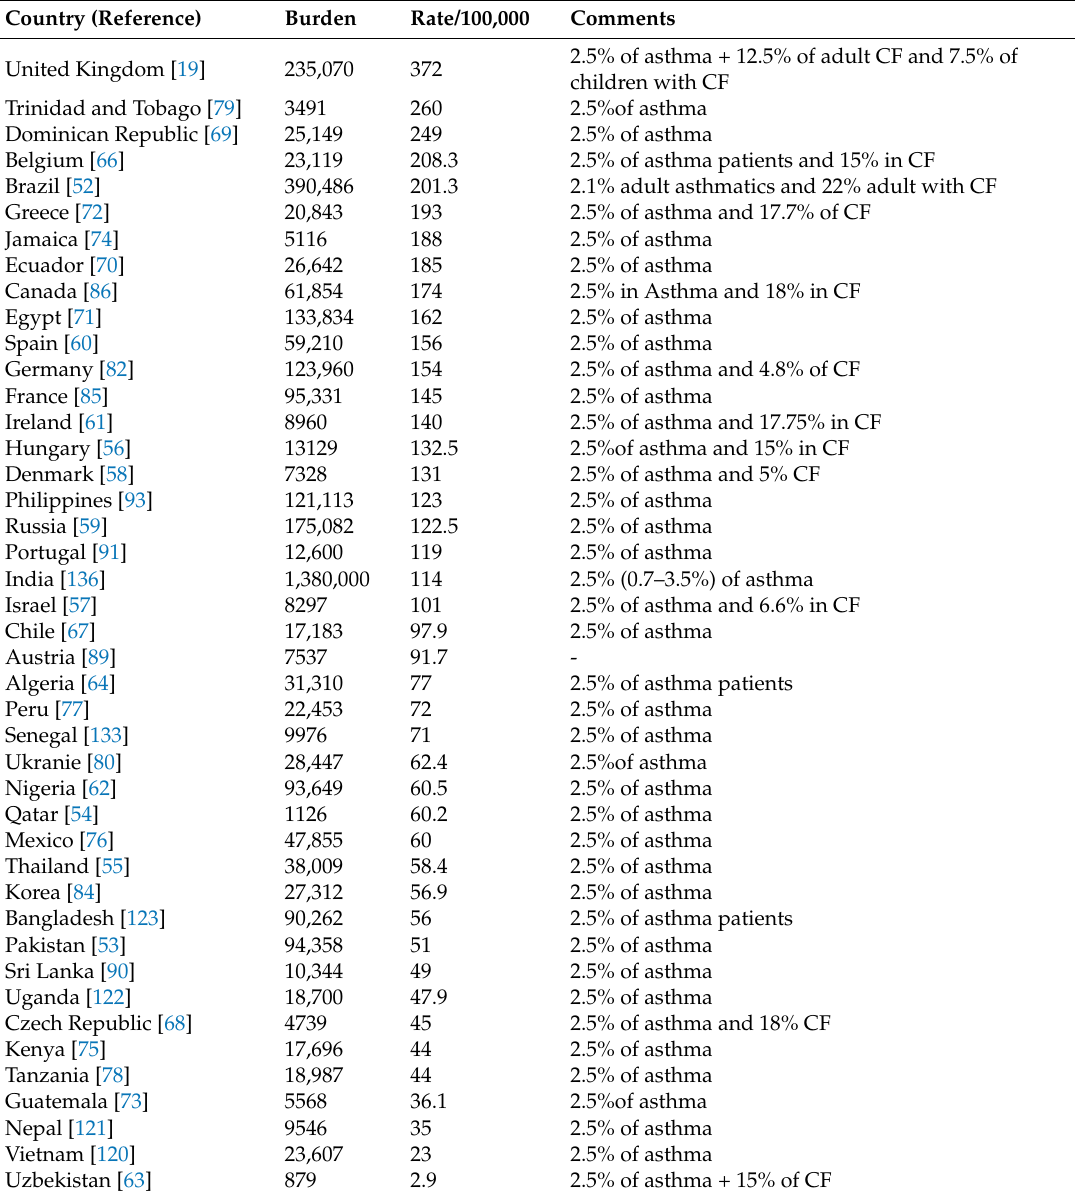
Table 6. Estimated burden of allergic bronchopulmonary